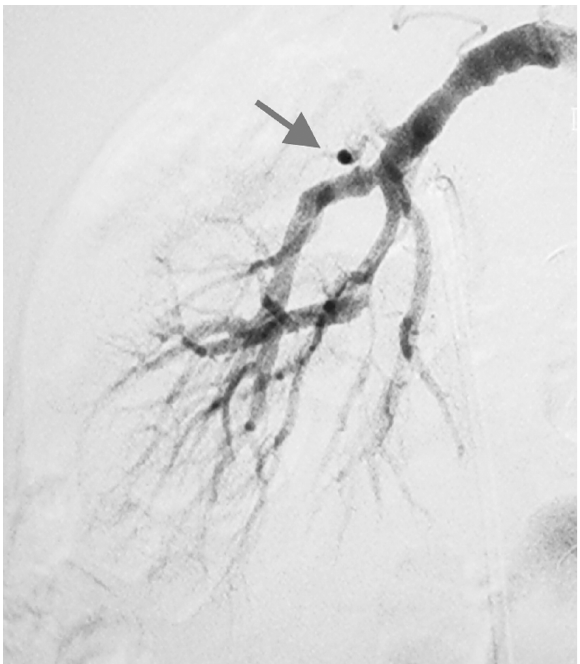
Figure 2 – Right renal arteriography following selective embo- lization of the upper pole (arrow).